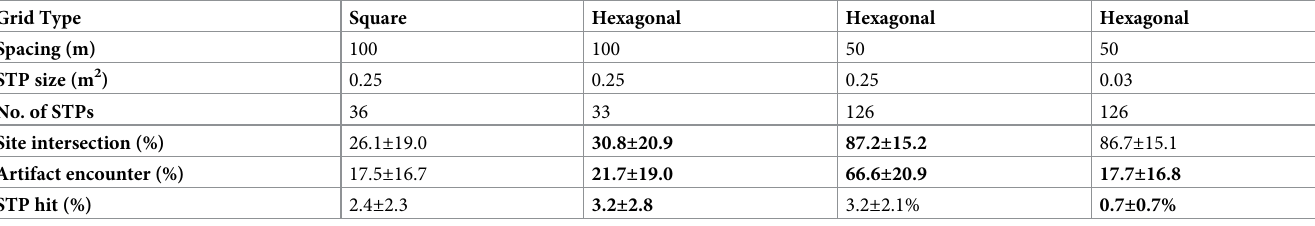
Table 1. Effectiveness and efficiency of square and hexagonal grids with 100 and 50 m spacings.